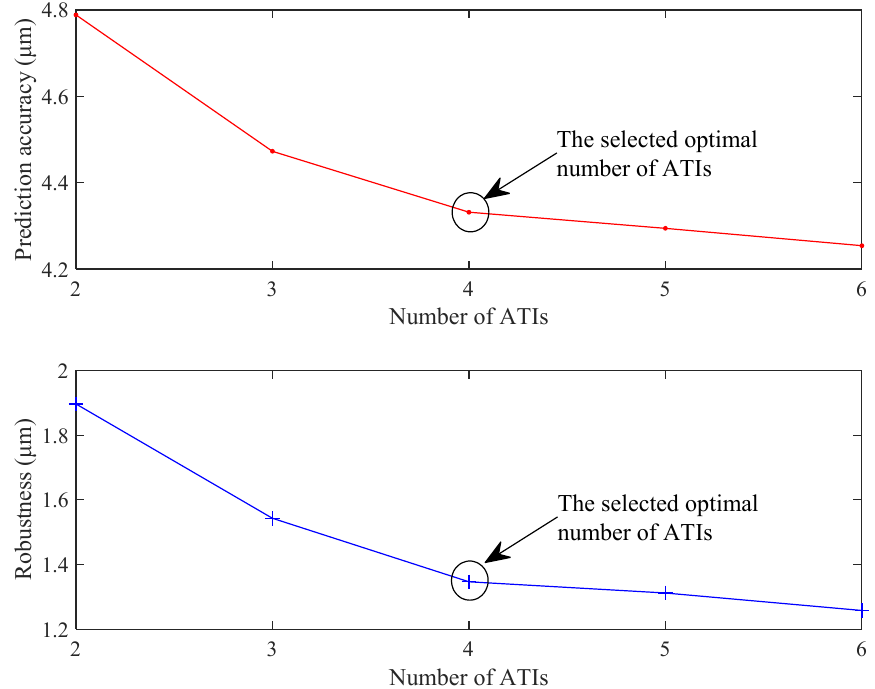
Figure 9. Prediction effects with different numbers of ATIs.